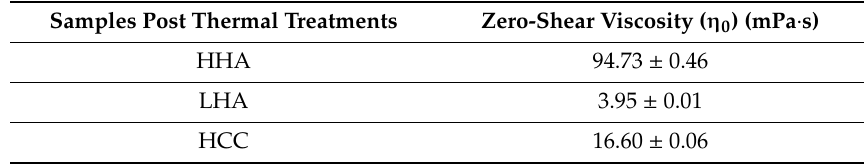
Figure 1. Refractive index (RI) measurements on Size Exclusion Chromatography -Triplo Detector Array (SEC-TDA) analyses. Overlay of HHA (red), LHA (violet), and HCC samples (green) after thermal treatment. Table 1. Zero-shear viscosity of HHA, LHA, and HCC at 0.4% w / v in PBS after thermal treatment.